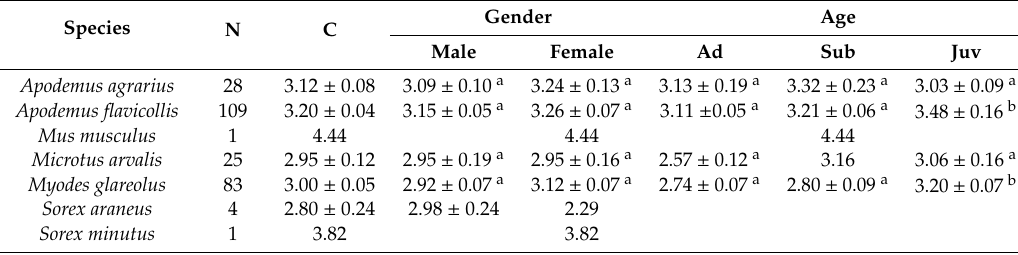
Table 3. Body condition (C ± SE) of the small mammals in the commensal habitats and breakdown for animal gender and age.